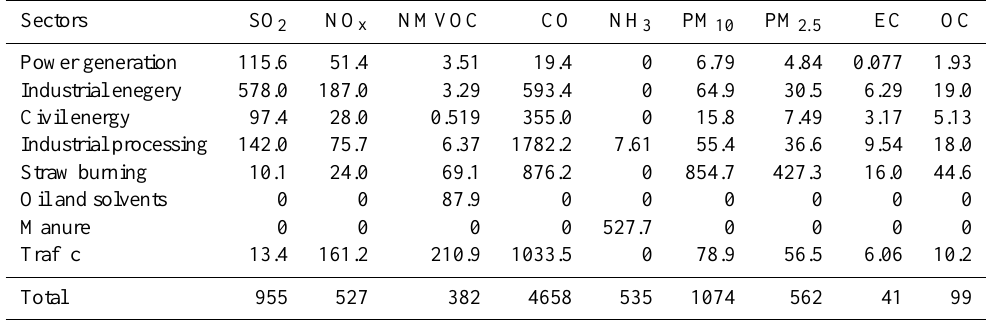
Table 12. Anthropogenic emissions by sector in the larger Huabei region in 2003 (units: 10 4 tonyr − 1